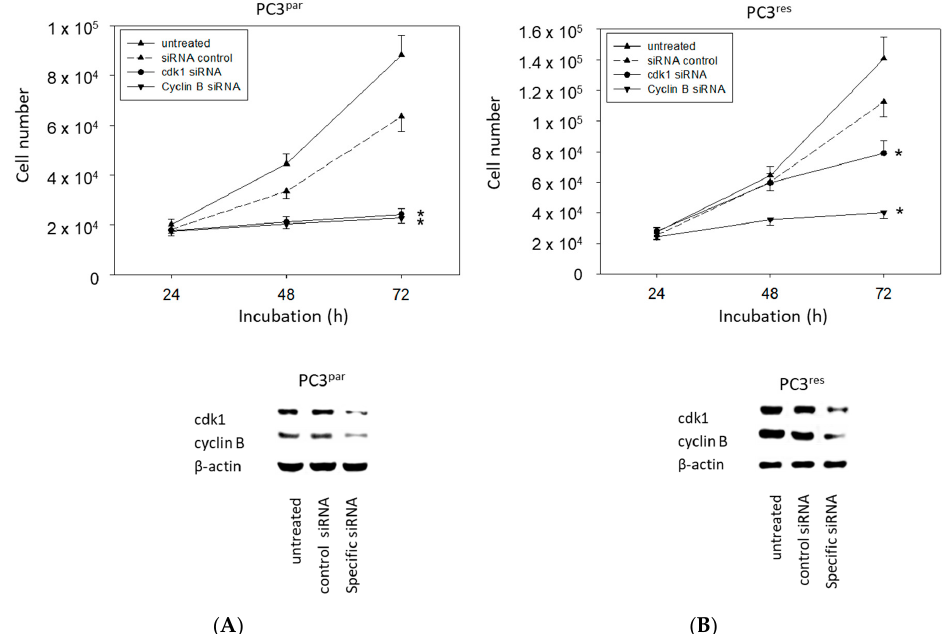
Figure 6. Cell growth after functional blocking with small interfering RNA (siRNA) targeting cdk1 and cyclin B of ( A ) PC3 par and ( B ) PC3 res cells. Controls remained untreated. Lower panel: Protein expression profile of cdk1 and cyclin B after functional blocking with siRNA. β -actin served as internal control. One representative of three separate experiments is shown. * indicates significant difference to control.